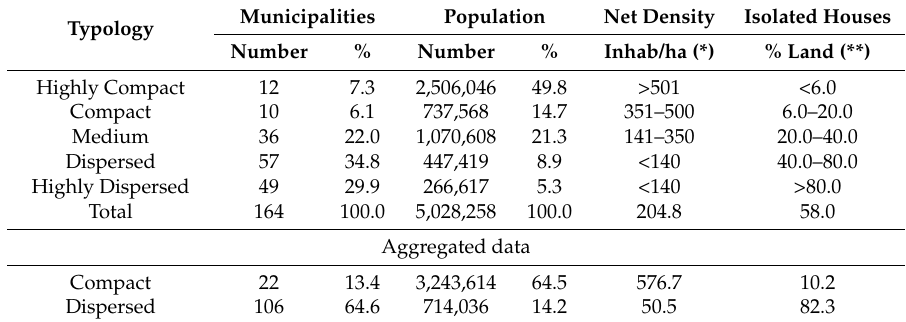
Table 1. Classification of Barcelona Metropolitan Region (BMR) municipalities by urban